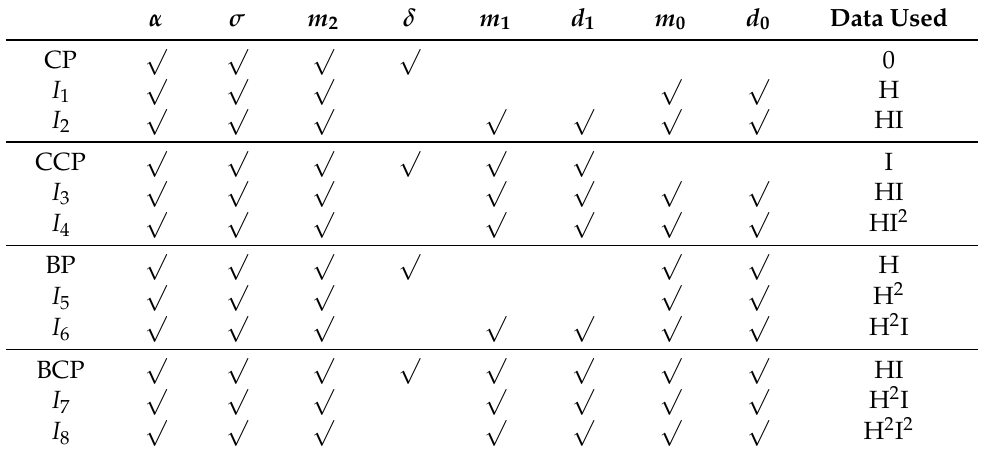
Table 1. The 4 powers and the 8 predictive powers as functions of the parameters, and the data used. α σ m 2 δ m 1 d 1 m 0 d 0 Data